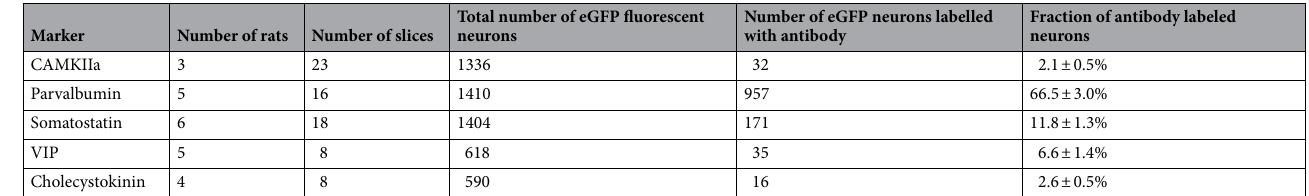
Table 2. Summary of rAAV2 PV-eGFP co-expression in area V1/V2.